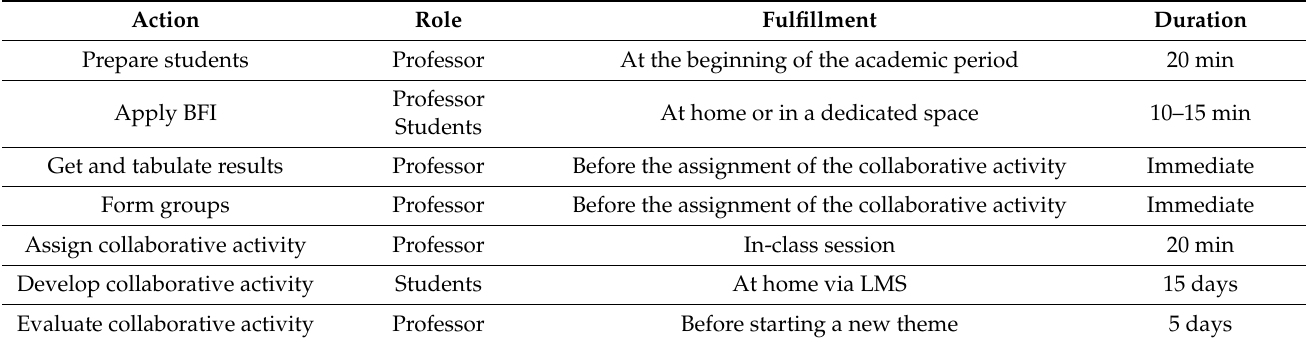
Table 8. Actions to support the different themes in the experimental courses.